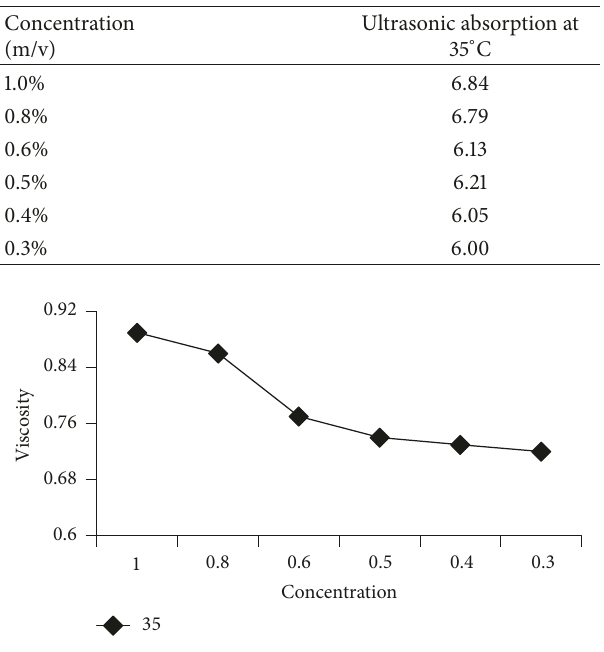
Figure 2: Variation of viscosity with concentration at 35 ∘ C temper- ature.